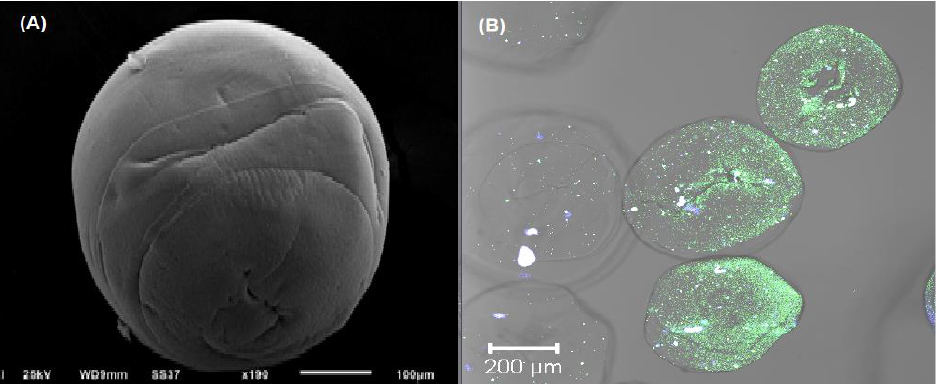
Figure 1. SEM and confocal images of alginate microcapsule beads with lipase (MC-CALb). ( A ) With a characteristic morphology at ×1000 magnification; ( B ) fluorescence microscopy images at ×400 a characteristic morphology at × 1000 magnification; ( B ) fluorescence microscopy images at × 400 magnification of CALb-alginate microcapsules. magnification of CALb-alginate